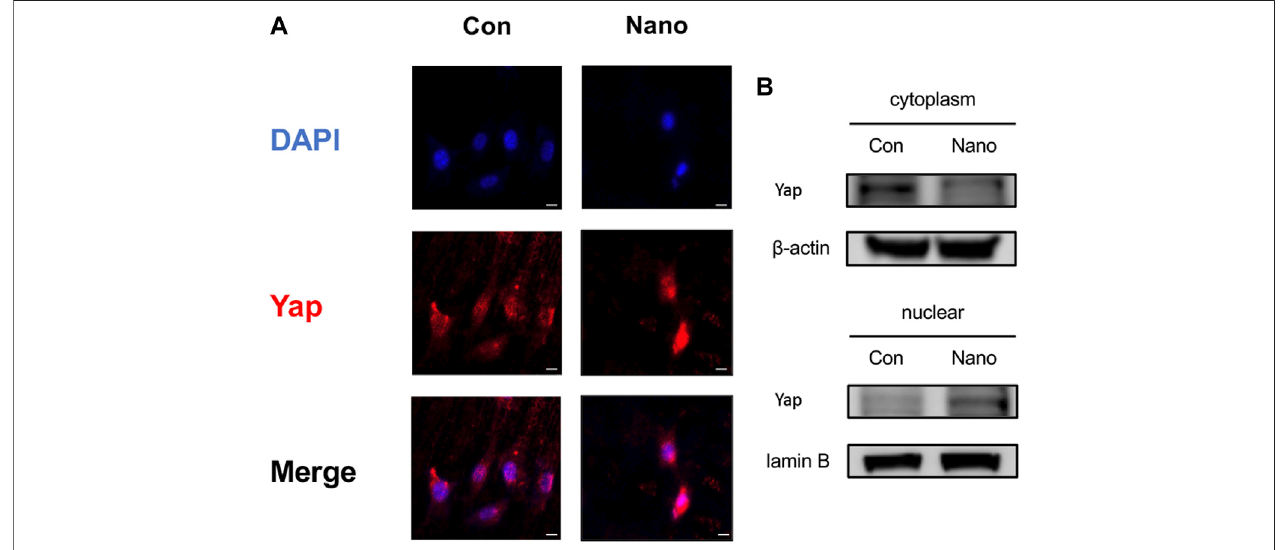
FIGURE 3 | Yap entering the nucleus plays an important role in nanotopography-related osteogenesis. (A) Immuno fl uorescence staining of Yap proved the accumulation of Yap in the nucleus under stimulation of nanotubes. Scale bar: 10 μ m. (B) Western Blot of Yap in the nucleus and cytoplasm proved its accumulation in the nucleus when seeded on